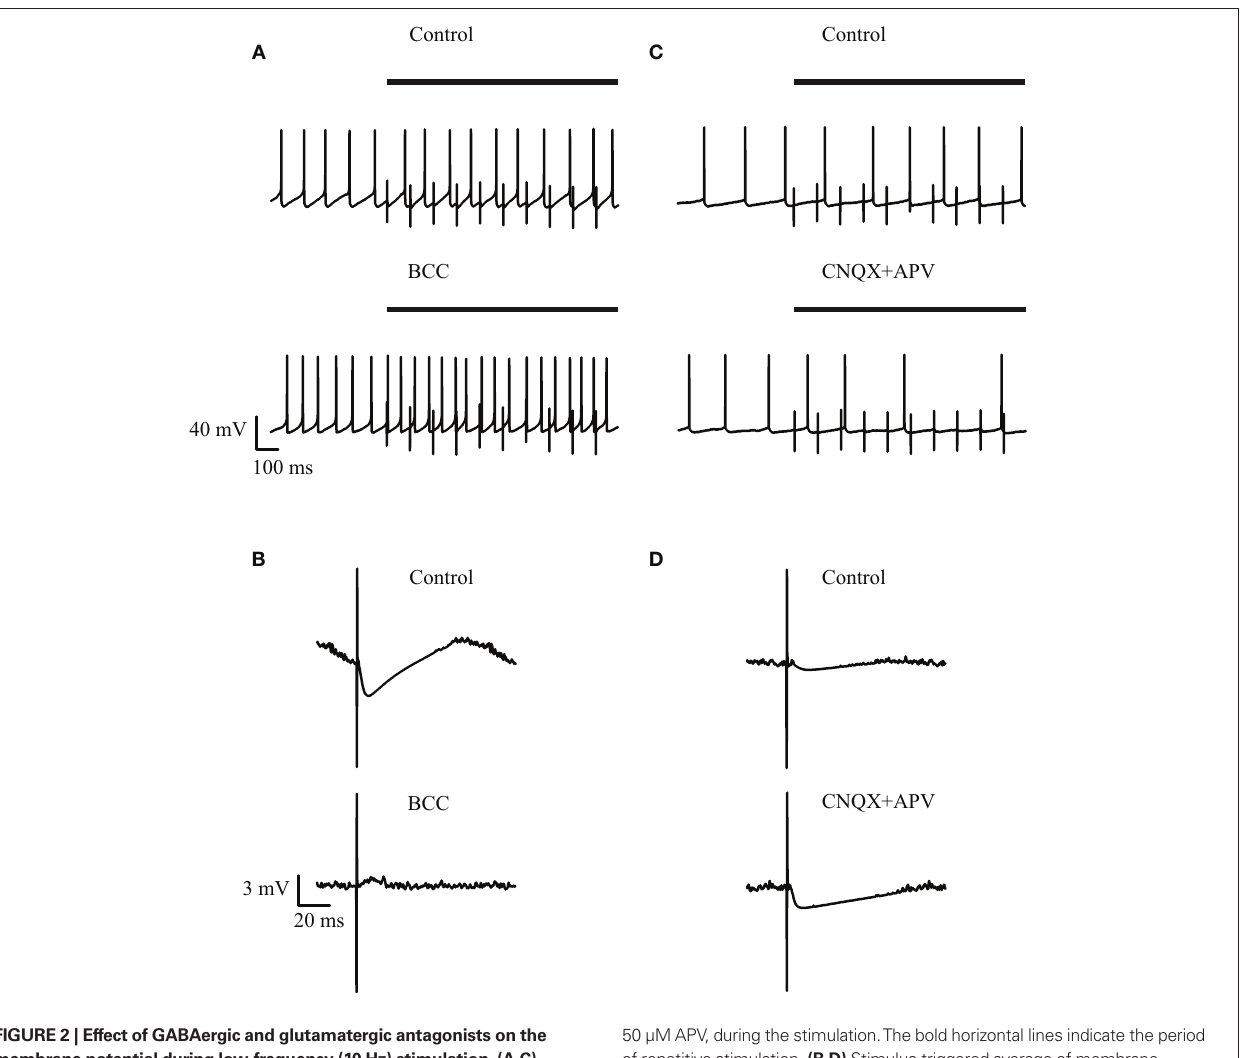
Figure 2 | effect of gABAergic and glutamatergic antagonists on the membrane potential during low-frequency (10 Hz) stimulation. (A,C) Continuous recording of the membrane potential before (top trace) and after (bottom trace) application of (A) 50 μM bicuculline or (C) 15 μM CNQX and